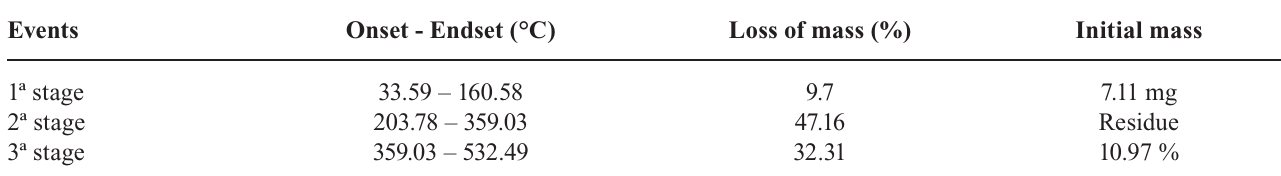
TABLE III - Data of thermogravimetric curve of the roots from T. inamoema, with their respective losses of mass, in each temperature range (°C)